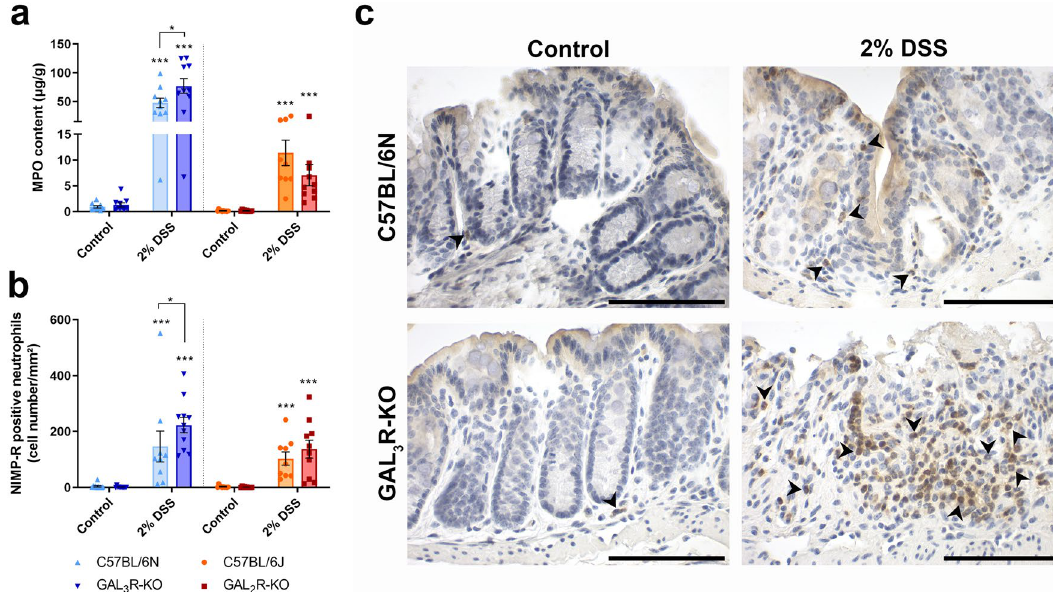
Figure 4. Infiltration of the colon by neutrophils in GAL 3 R-KO, GAL 2 R-KO and corresponding WT mice was evaluated by neutrophil-derived MPO content ( a ) and numbers of NIMP-R14 + neutrophils ( b ). Data represent means ± SEM. n = 9–11. Data were analyzed by Kruskal–Wallis test followed by Mann–Whitney-U test. * p < 0.05; *** p < 0.001 versus corresponding controls or as indicated. Representative images of IHC staining of murine colon samples against NIMP-R14 in C57BL/6N and GAL 3 R-KO mice ( c ). Arrowheads indicate NIMP-R14- positive neutrophils. Scale bar: 50